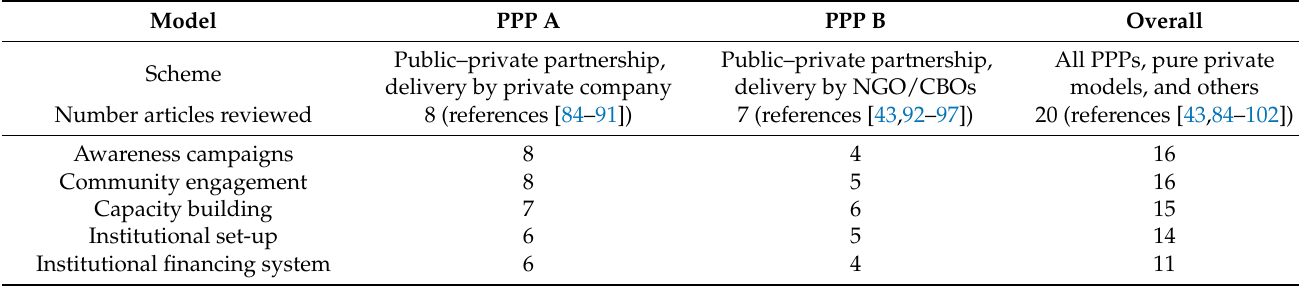
Table 4. Ranking of the relevance of political economy criteria. Note: “Capacity building” includes local capabilities, and “Institutional set-up” includes network and context of institutions and other formalized